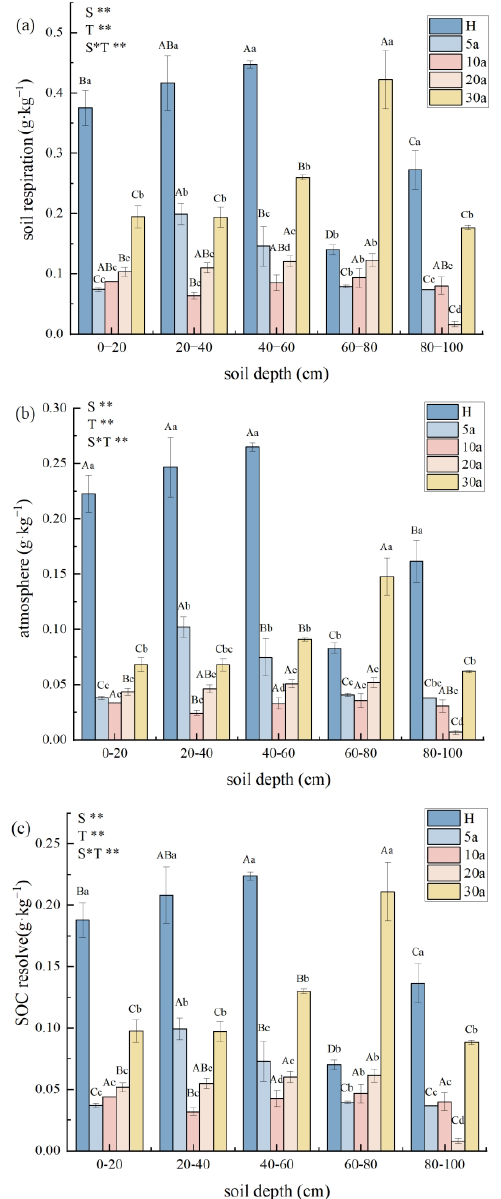
Figure 5. Sources of CO 2 fixed by soil SIC and its carbon change/g · kg − 1 . ( a ) is the amount of CO 2 from soil respiration, ( b ) the amount of CO 2 from atmospheric fixation, and ( c ) the amount of CO 2 from oxidative decomposition of SOC. Note: Different capital letters indicate significant differences between different soil depths for the same succession year, and different lowercase letters indicate significant differences between different continuous cropping years for the same soil depth; S indicates the main effect of different continuous cropping years, T indicates the main effect of different soil layers, and S*T indicates the interaction effect of different continuous cropping years with different soil layers; ** indicates highly significant correlation ( p < 0.01), and * indicates significant correlation ( p <